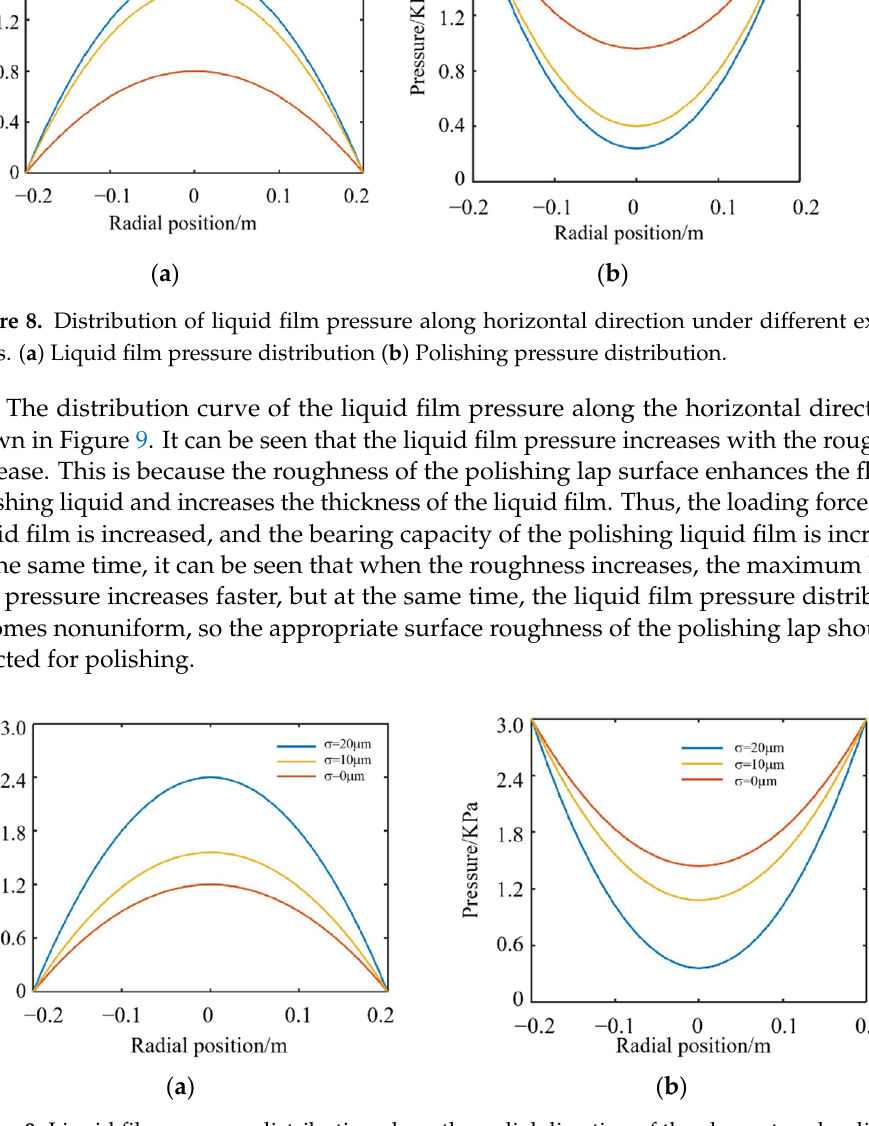
Figure 9. Liquid film pressure distribution along the radial direction of the element under different roughness. ( a ) Liquid film pressure distribution; ( b ) Polishing pressure distribution.